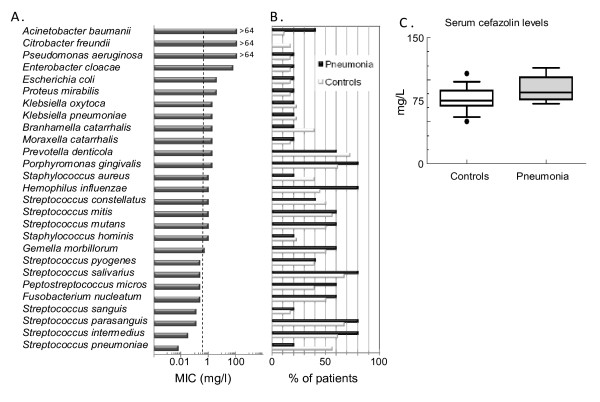
Minimal inhibitory concentrations (MIC) of cefazolin and its concentration in serum. Neither cefazolin sensitivity of the bacteria isolated from the saliva/bronchial secretions nor serum cefazolin levels were different between control and pneumonia patients. Bacteria were isolated from the saliva pre- and postoperatively. Bronchial secretion and serum were obtained post-operatively for bacterial culture and determination of cefazolin levels. (A): Distribution of isolated bacteria according to their MIC values. The antibiotic level of all the saliva and bronchial secretion samples fell below 0.5 mg/L; marked by the vertical dashed line. (B): Distribution of isolated bacteria according to percentage of patients with that particular species in each group. (C): Serum cefazolin levels are expressed as "box and whiskers: 10–90 percentile" and compared using the non-parametric Mann-Whitney test between control and pneumonia patients (n = 18 and 5, respectively).